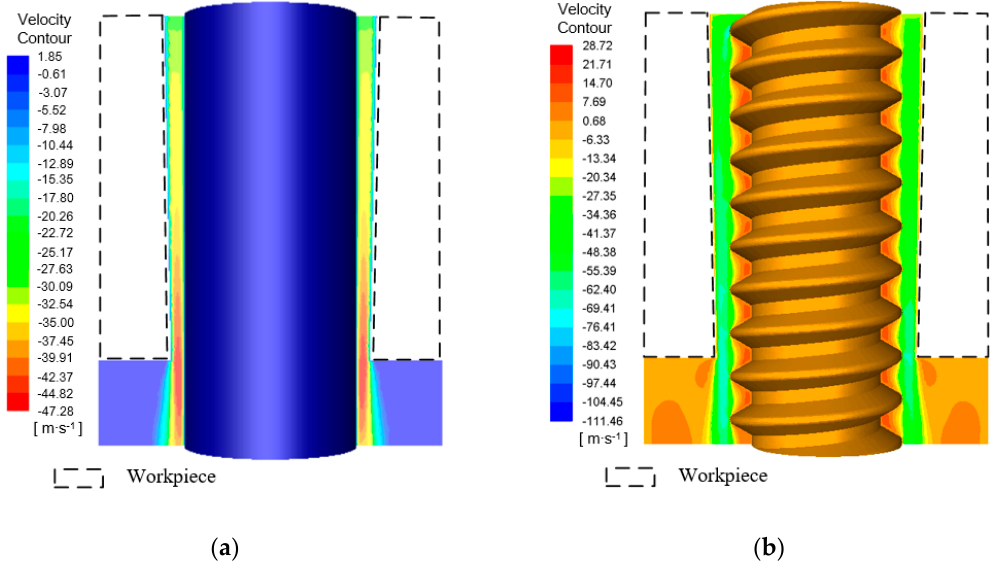
Figure 2. Velocity contours in the machining gap using different tube tool electrodes: ( a ) cylindrical tube electrode; ( b ) helical tube electrode.